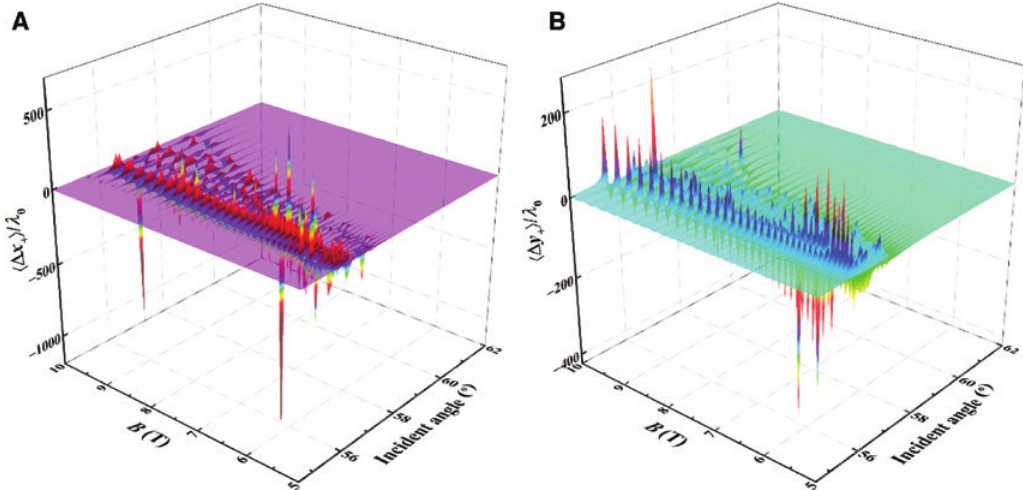
⟩ and ⟨ Δ y ⟩. They have a similar change tendency with the minimum + +